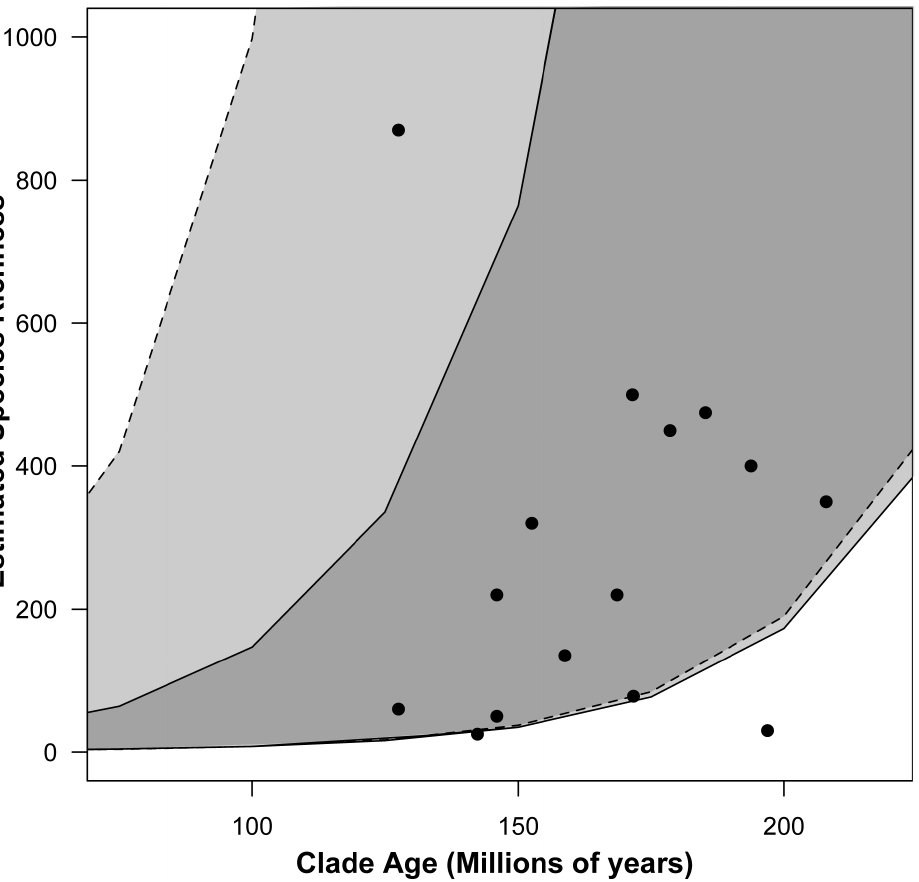
Figure 4. Relationship between clade age and estimated species richness in Hydrophilidae. The shaded regions show 95% confidence interval of the expected diversity under a low (e=0, solid lines) and high (e=0.9, dashed lines) extinction.